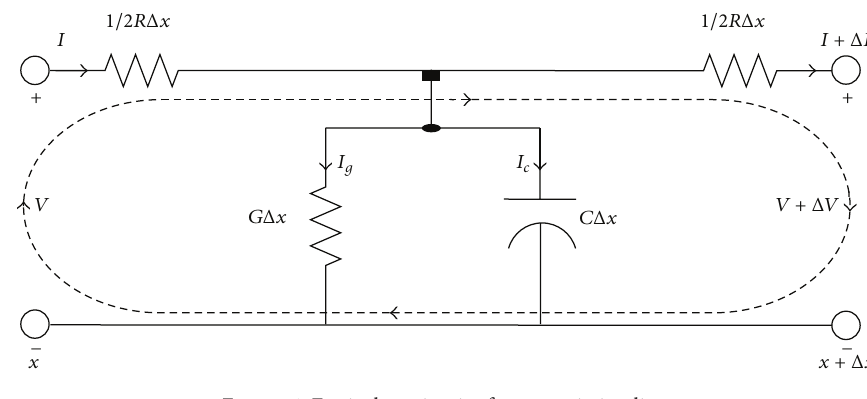
Figure 1: Equivalent circuit of a transmission